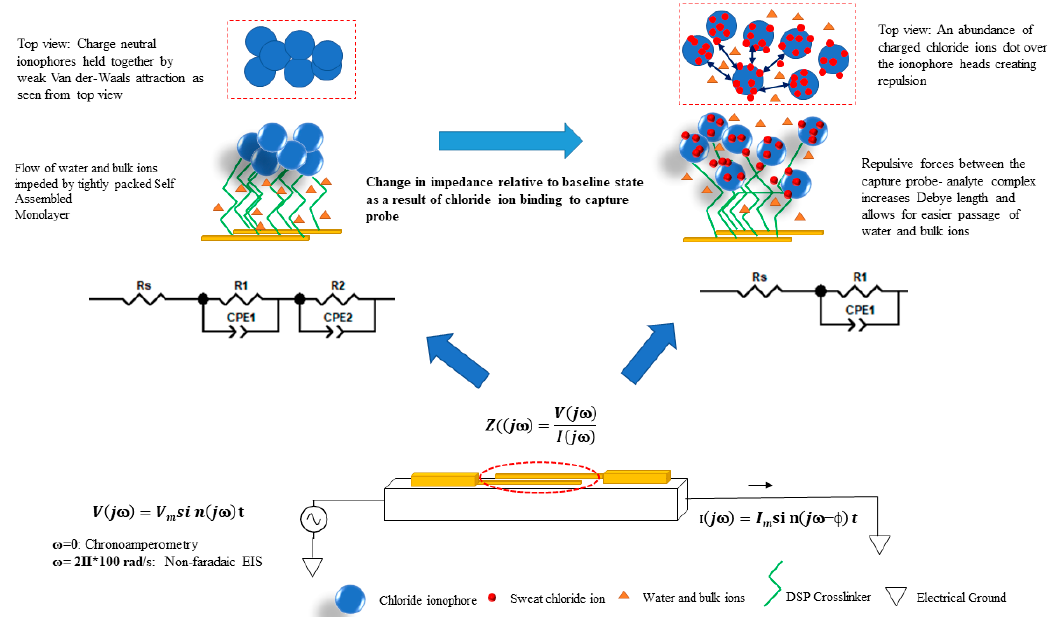
Figure 2. The proposed chloride sensor device can be used to measure chloride levels in ultra-low volumes of passively addressed sweat. Gold working and reference/counter microelectrodes have been deposited on the nanoporous polyamide substrate. The sensor stack consists of a chloride ionophore, a neutral organic bioinert molecule, to which sweat chloride ions preferentially bind through strong hydrogen bonds.